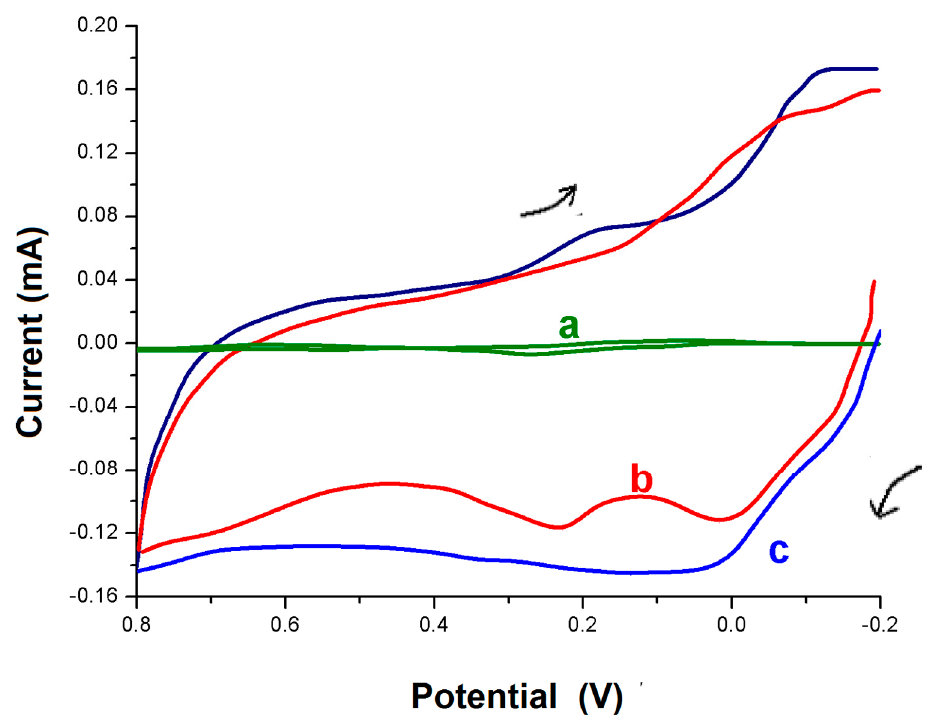
Figure 2. Cyclic voltammograms at a BCPE for detection of DA ( a ) and a polymer modified carbon paste electrode (PMCPE) ( b , c ) in the presence of 1 × 10 − 3 M dopamine (DA) ( b ) and in the absence of DA ( c ) in 0.1 M PBS (pH 7.0). Scan rate: 100 mV · s − 1 .